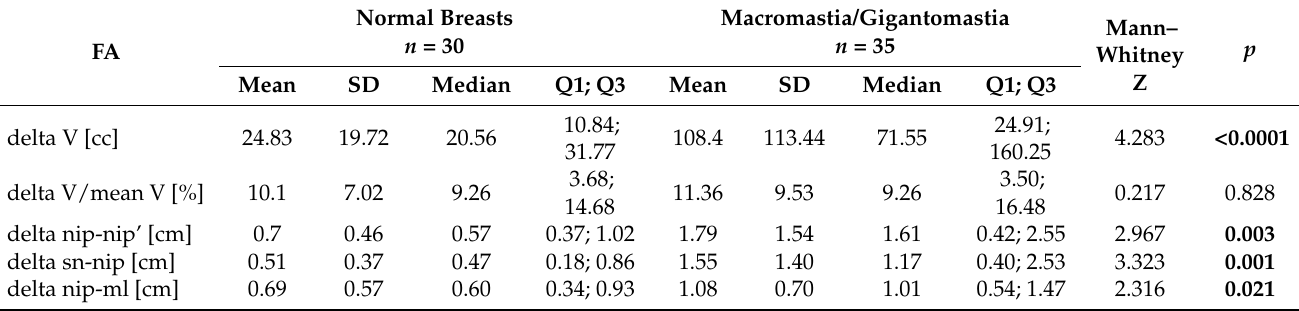
Table 3. Comparison between FAs of normal breasts versus